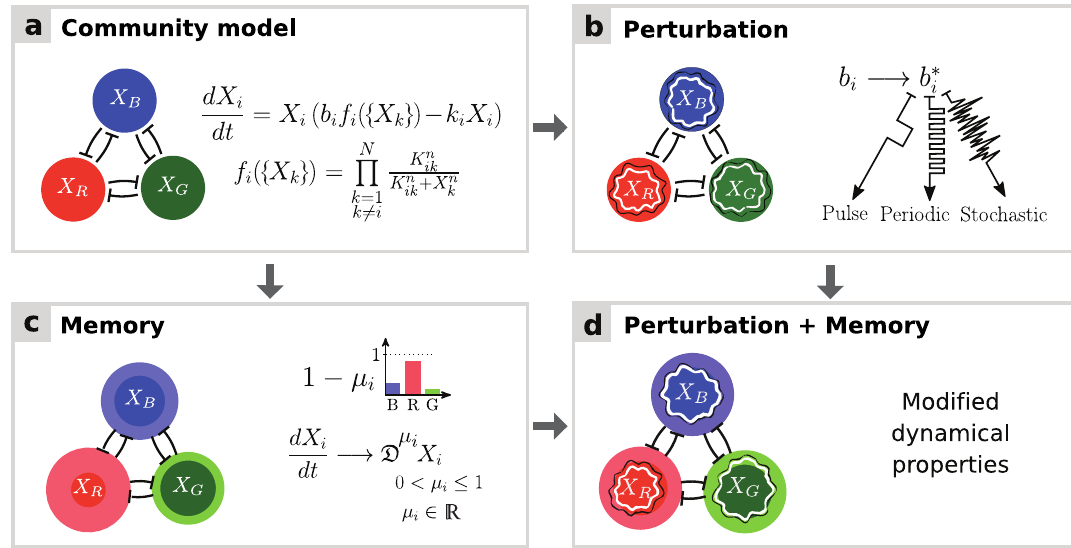
Fig 1. Schematic illustration of a three-species community in the presence of memory and perturbations. (A) Mutual interaction model introduced by Gonze et al. [25] to illustrate the emergence of alternative stable states in human gut microbial communities. The model describes the dynamics of species abundances X i as functions of growth rates b i , death rates k i , and inhibition functions f i , where K ij and n denote interaction constants and Hill coefficients, respectively. (B) Standard perturbations include pulse, periodic, and stochastic variation in species immigration, death, or growth rates. Such perturbations may trigger shifts between alternative states. (C) Memory (bolded circles) can be incorporated into dynamical models by substituting the integer-order derivatives with fractional derivatives D m i of order μ (see [37] and Methods). As decreasing μ values correspond to increasing memory, memory is measured as 1 i i − μ i . When all community members have the same memory ( μ i = μ for all i ), the system is said to have commensurate memory, otherwise incommensurate . Increasing memory changes community dynamics, in particular by introducing inertia and modifying the stability landscape around stable states. (D) Ecological memory can change the system dynamics under